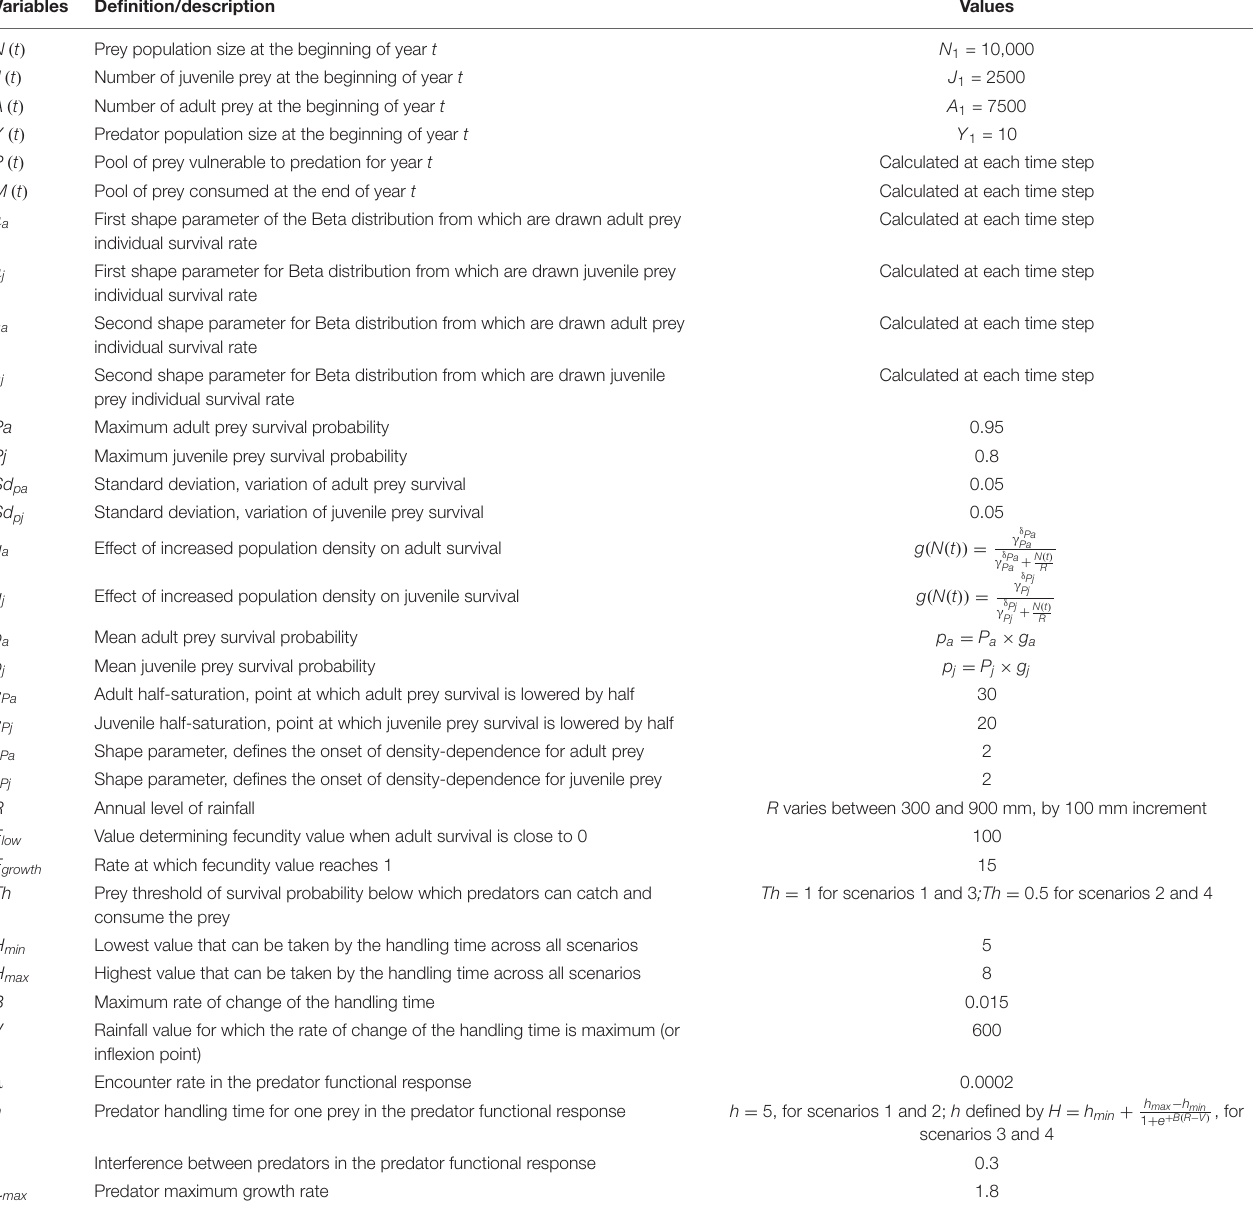
TABLE 1 | Definitions and values of the state variables and parameters for prey and predators used in the